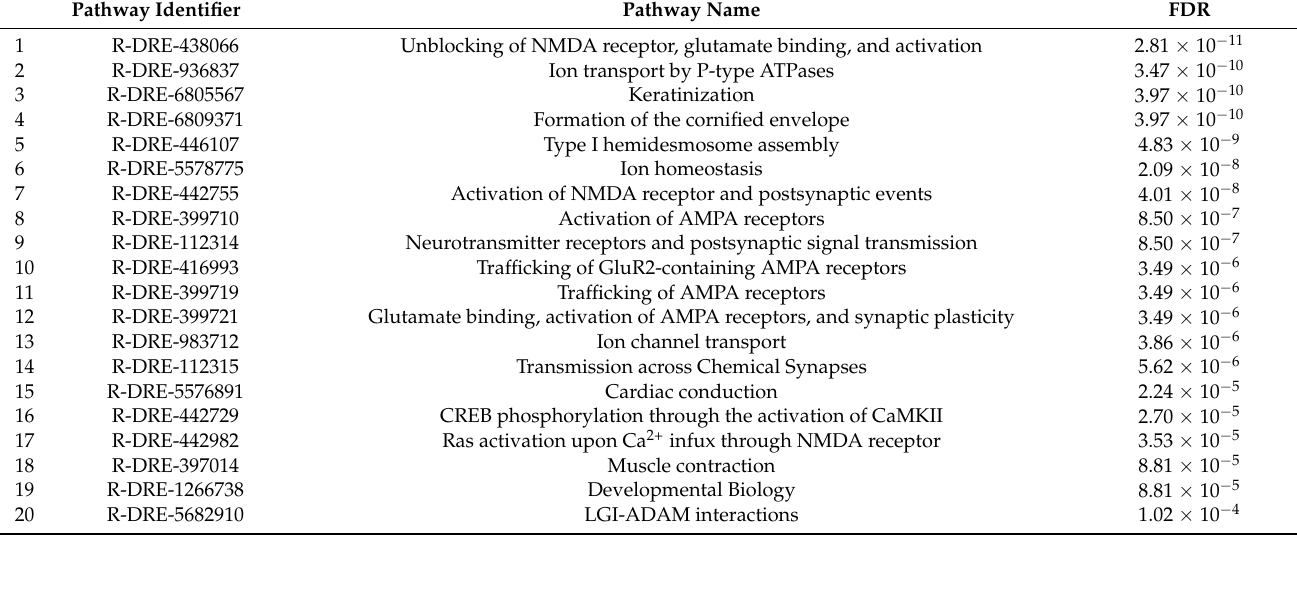
Table 1. The most significant Reactome database paths detected based on the 157 identified transcripts.